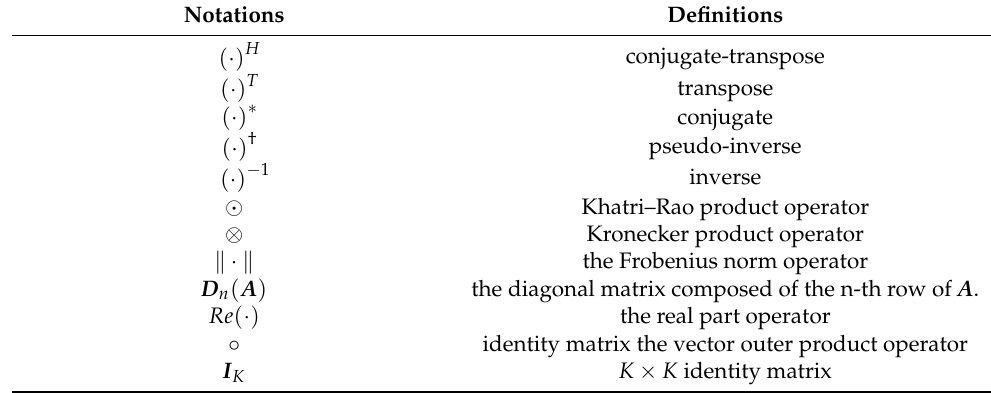
Table 1 defines the symbols in this paper. Table 1. Related